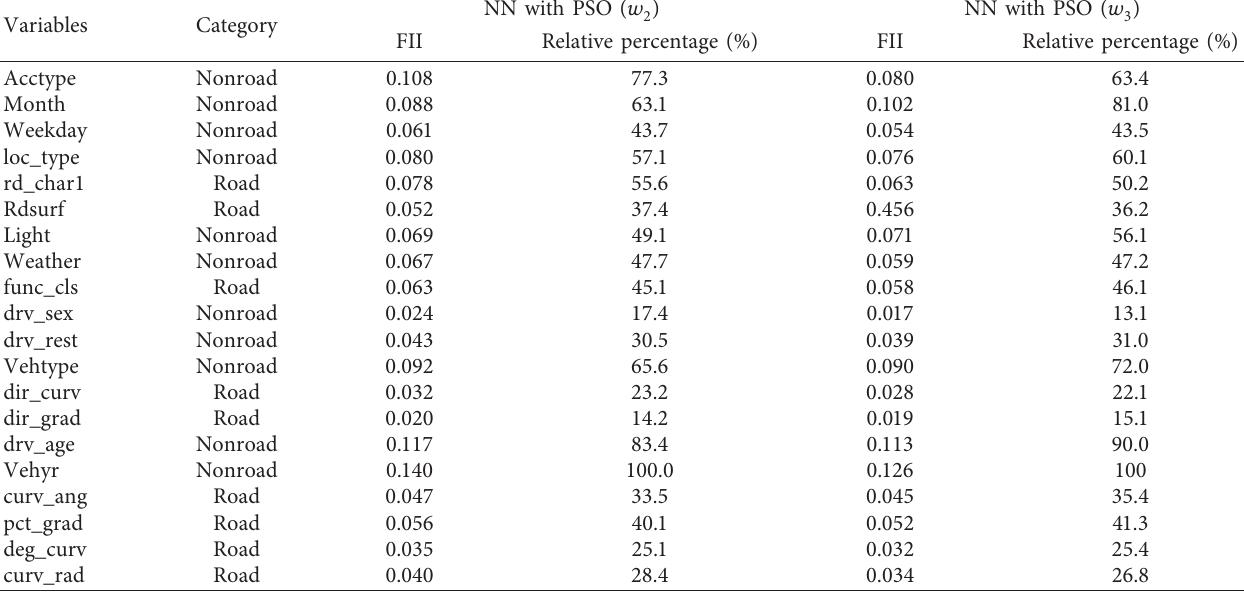
Table 5: Summary of FII expectation ( K � 100) and relative percentage for two different